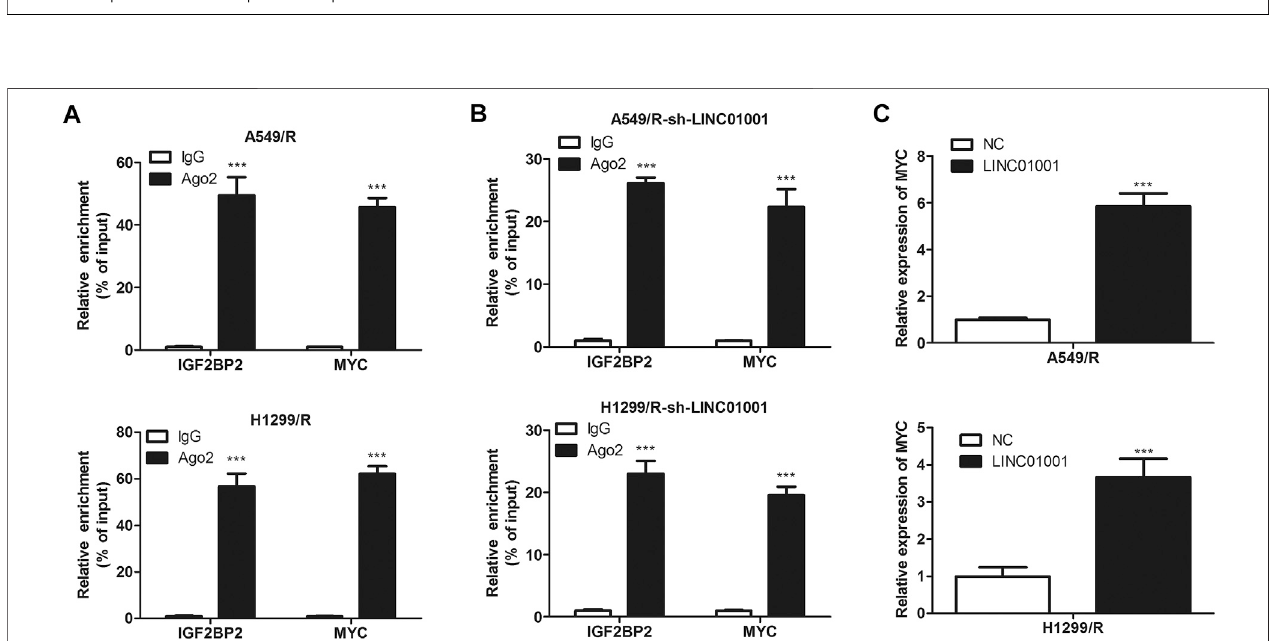
FIGURE 7 | IGF2BP2 interacts with the mRNA of MYC. (A) RIP assay evaluated the interaction between IGF2BP2 and MYC mRNA in A549/R cells. (B) RIP assay evaluated the interaction between IGF2BP2 and MYC mRNA in LINC01001 knockdown A549/R cells. *** p < 0.001 vs IgG group (C) RT-qPCR assessed the level of MYC mRNA. *** p < 0.001 vs NC group. Error bars represent SD. Data represent three independent experiments.